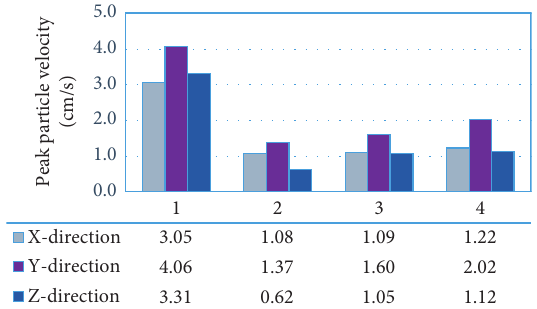
Figure 12: The peak particle velocity in X, Y , and Z directions.